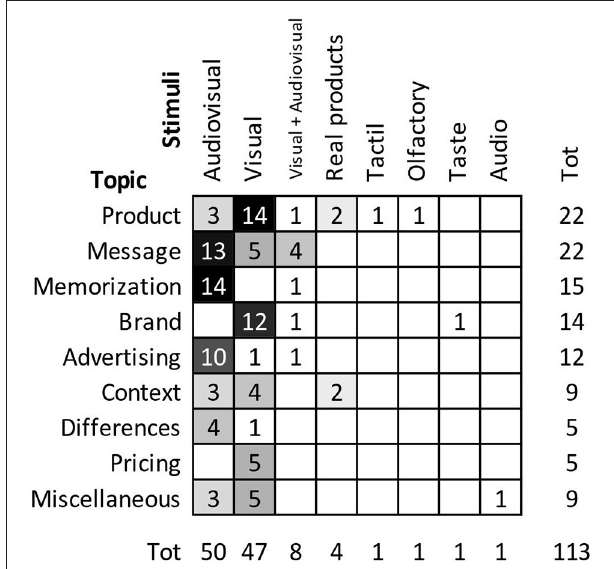
FIGURE 5 | Distribution of articles based on research topic and type of stimuli used. Visual indicates static visual stimuli (e.g., picture), audiovisual indicates dynamic stimuli (e.g.,